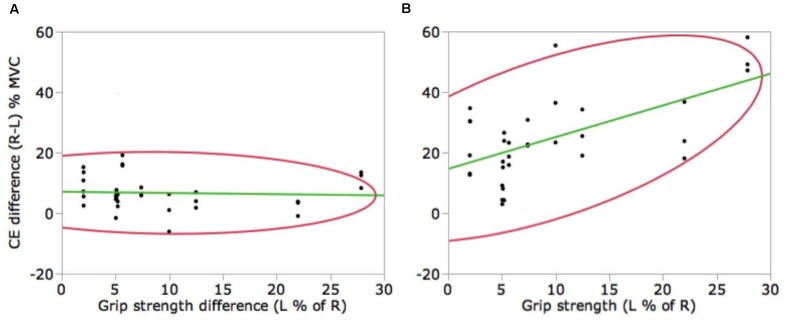
Correlation between the difference in right and left-hand CE (in % MVC) and the difference in hand strength (in % MVC) for the 20% MVC
(A) and 70% MVC (B) reference force levels. Correlation is significant only for the 70% MVCREF (P < 0.001).